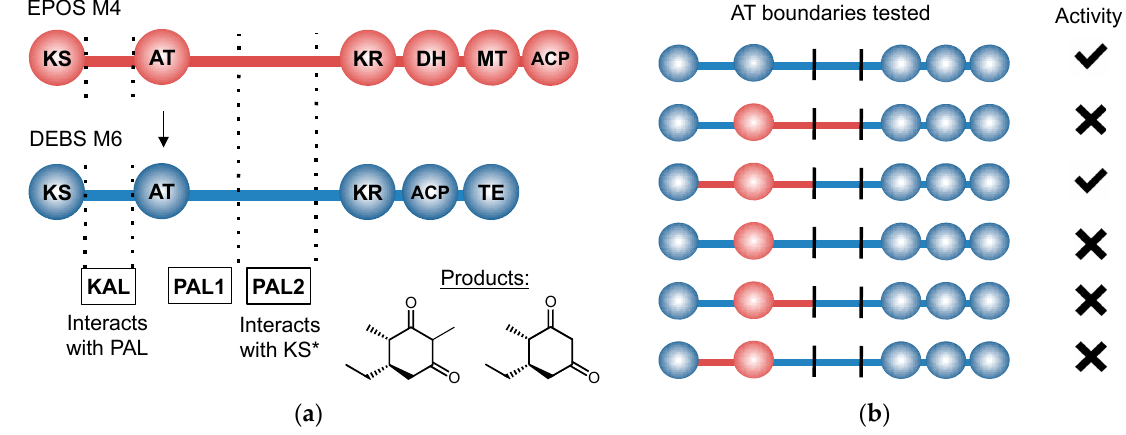
Figure 7. ( a ) Boundaries selected for AT-swapping experiments by Yuzawa et al. and the ( b ) outcome of assorted boundary combinations. Activities reported are relative to that of wild-type. KAL and PAL denote KS-AT linker and post-AT linker, respectively.